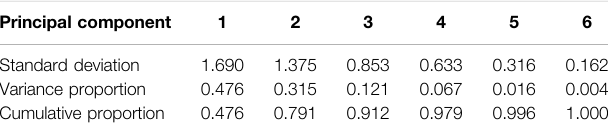
TABLE 1 | Standard deviation and variance proportion of principal components for PCA feature